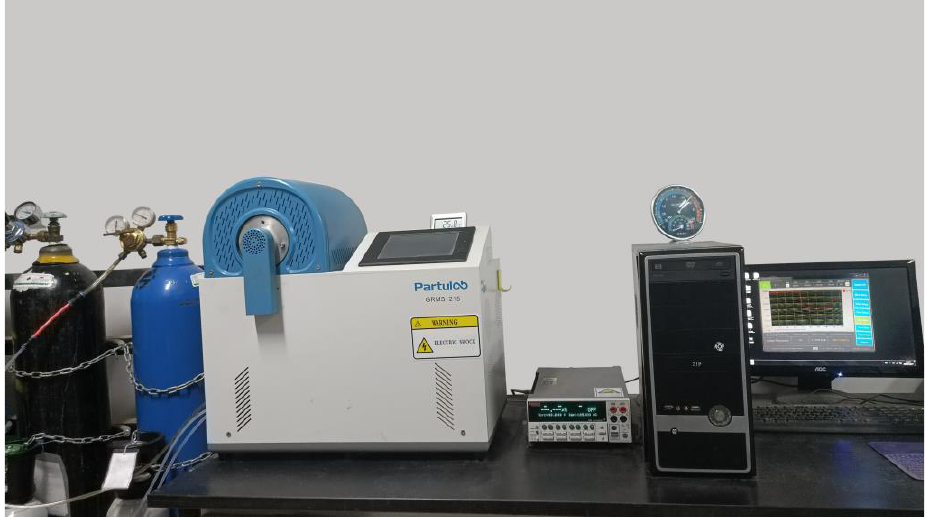
Figure 1. Photograph of the commercial gas sensing system (GRMS-215, Partulab Com., Wuhan, China) used in this study.